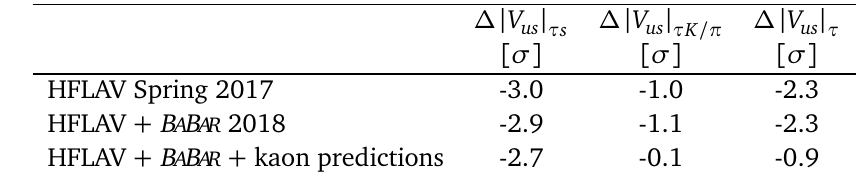
| obtained with us | determinations performed us